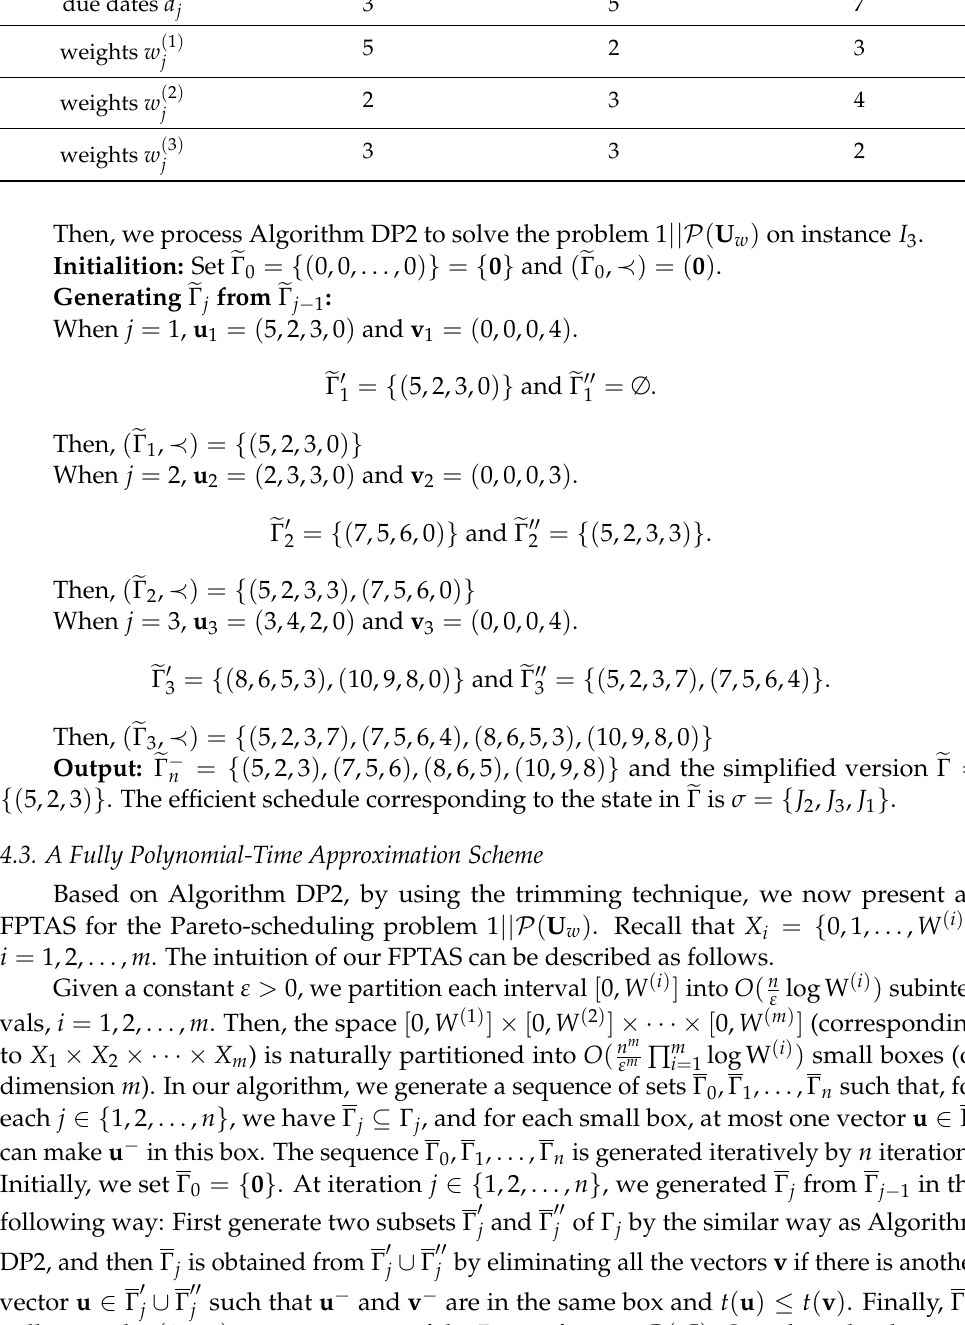
Algorithm DP2( ε ): An FPTAS for the problem 1 ||P ( U w )